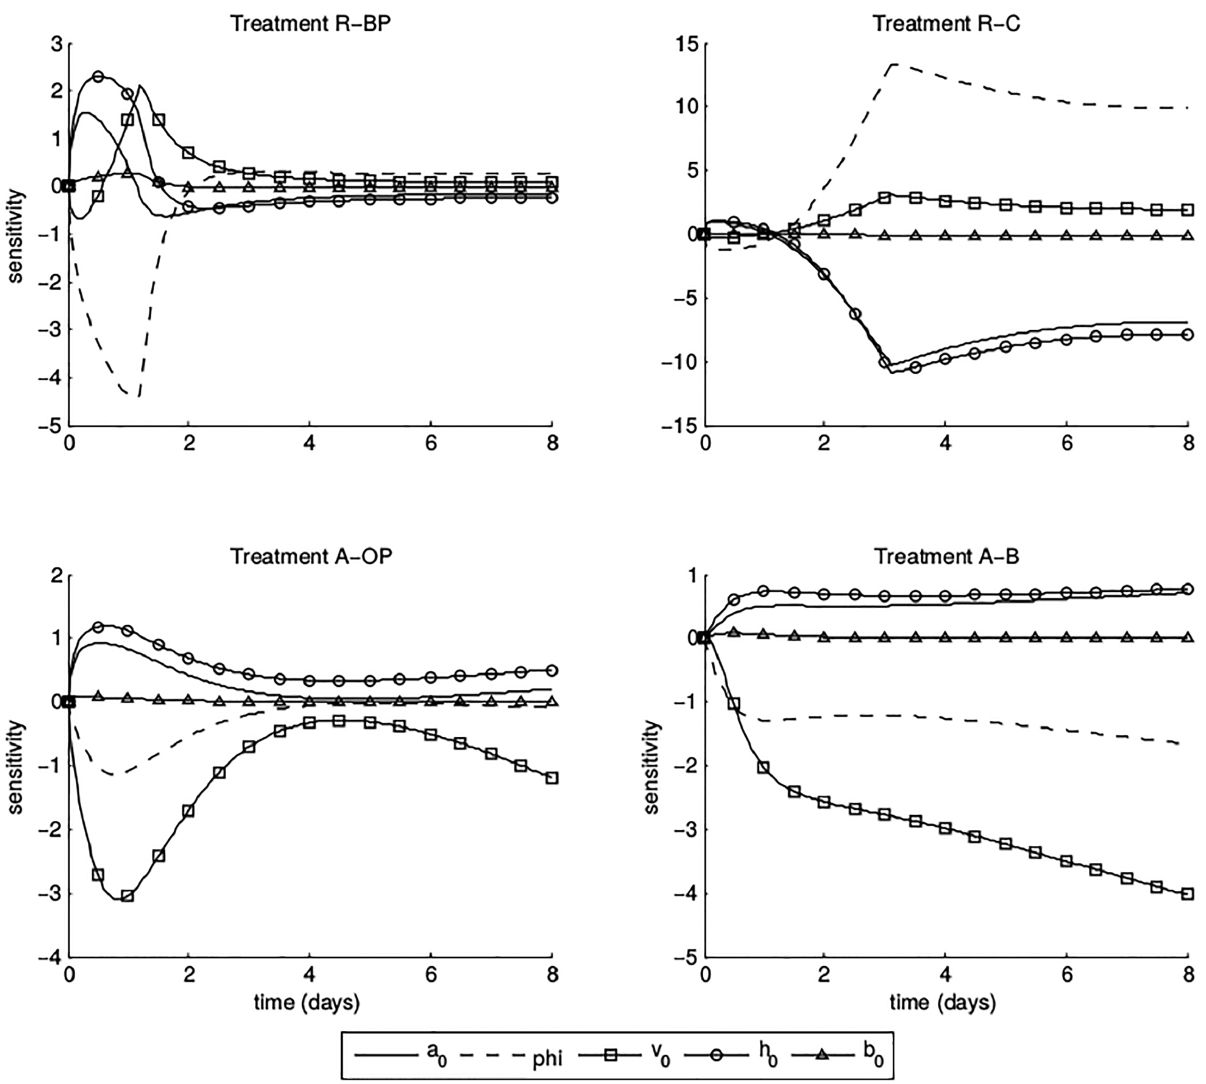
Fig 2. Sensitivities of aphid population abundances with respect to model parameters. Upper left: R . padi with predator treatment Bembidion- Pardosa . Upper right: R . padi with predator treatment Coccinella . Lower left: A . pisum with predator treatment Orius-Pardosa . Lower right: A . pisum with predator treatment Bembidion . Sensitivities are plotted in time and different parameters are indicated by line style.